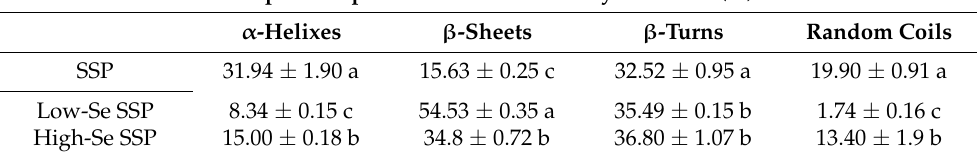
Table 1. Estimation of the secondary structural composition of SSP, low-Se SSP, and high-Se SSP by FT-IR